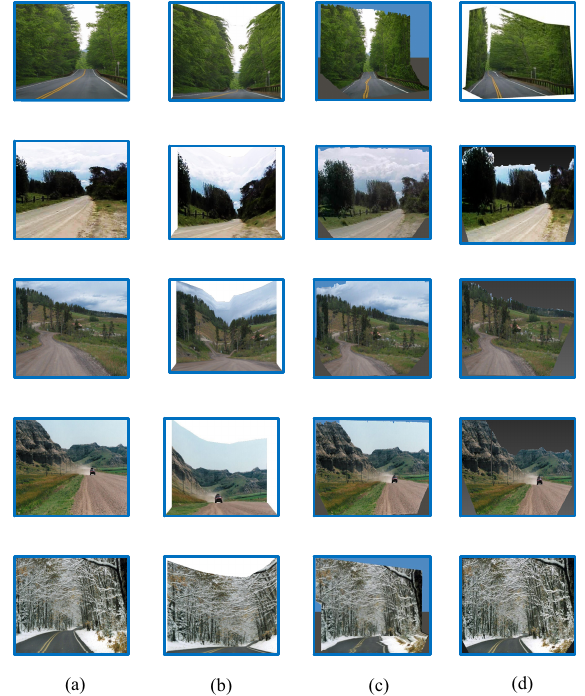
Figure 11. Comparison of 3D traffic scene construction methods. ( a ) input images; ( b ) proposed method; ( c ) Make3D; ( d ) photo pop-up.